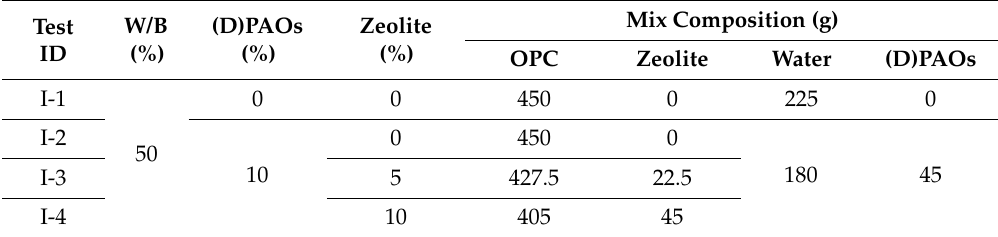
Table 5. Mix proportion of the mortar produced with (D)PAOs and zeolite.